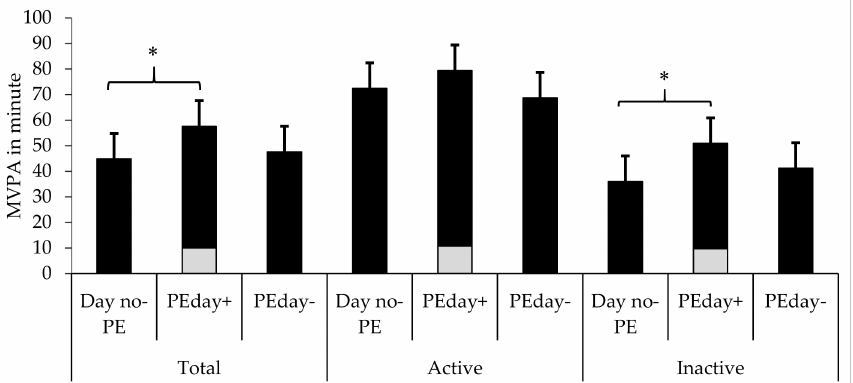
Figure 1. Adjusted time spent on MVPA on Day no-PE, PEday + , and PEday − by the total sample, and by active and inactive schoolchildren. Gray squares refer to MVPA in PE. *Significant di ff erences between